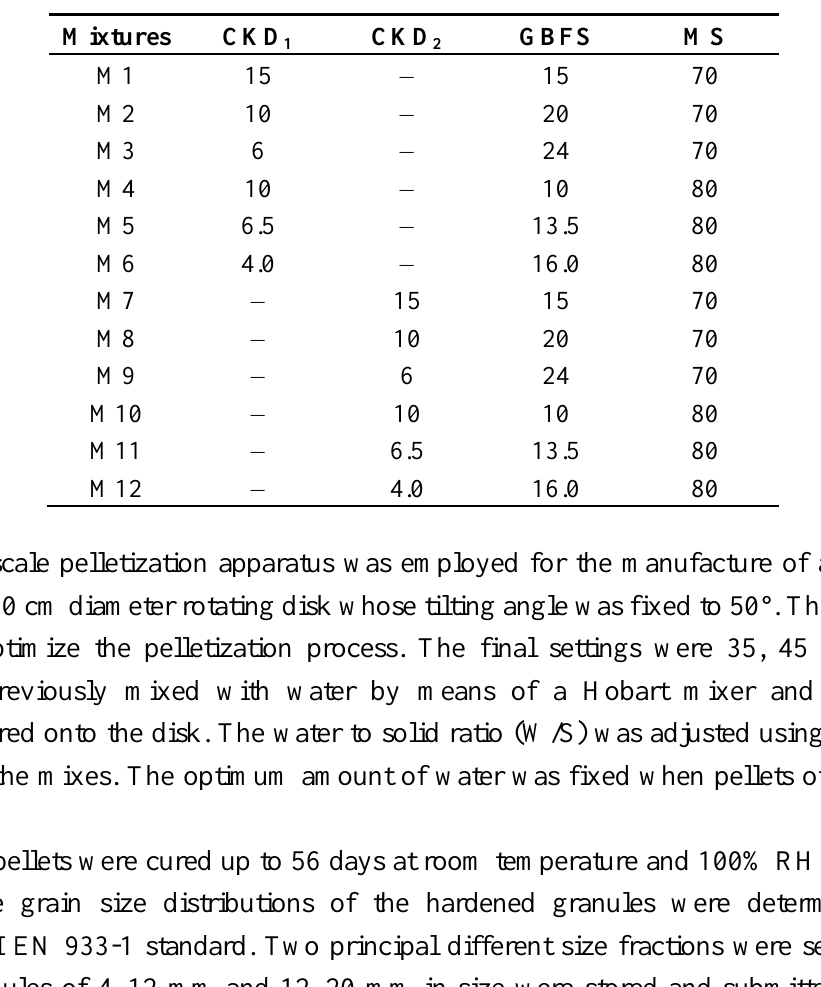
Table 2. Pellets composition (wt